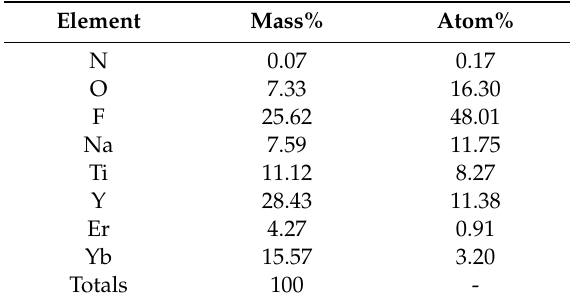
Table 4. Elemental analysis for CNS-TiO 2 /NaYF 4 :Yb,Er.